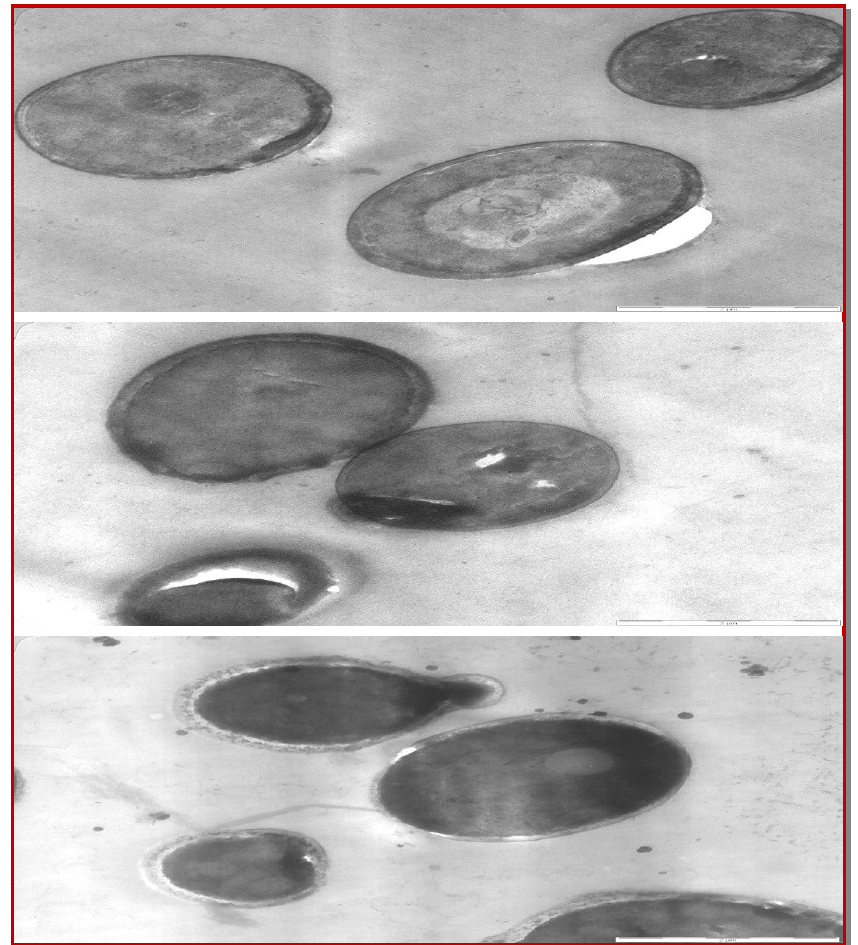
Figure 2: TEM results for C. albicans cells treated with H. littoralis’s flower and root extract at MIC value. 1a: control; 1b and 1c: flower and root extract treated C. albicans at magnification of 4000